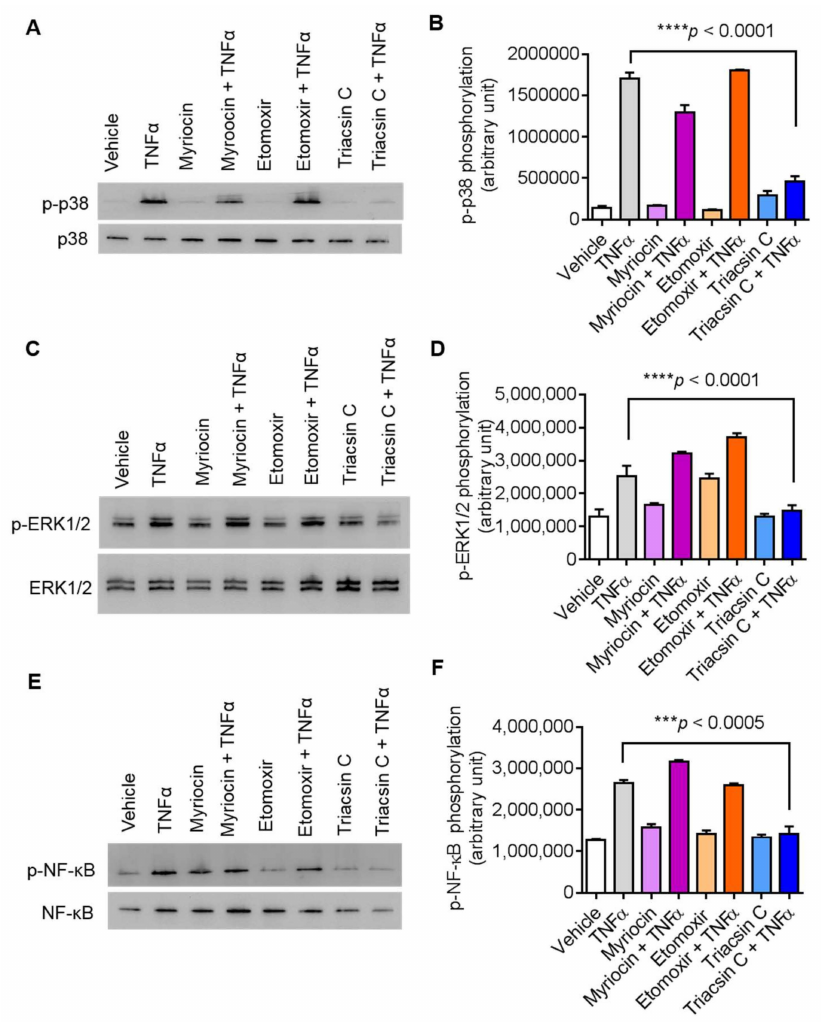
Figure 5. Inhibition of ACSL1 a ff ects TNF α -activated MAPK and NF- κ B signaling pathways in MDA-MB-231 cells. As shown in Figure 4A, TNF α treatment increases the phosphorylation of p38 MAPK, ERK1 / 2, and NF- κ B in a time-dependent manner. MDA-MB-231 cells were pretreated